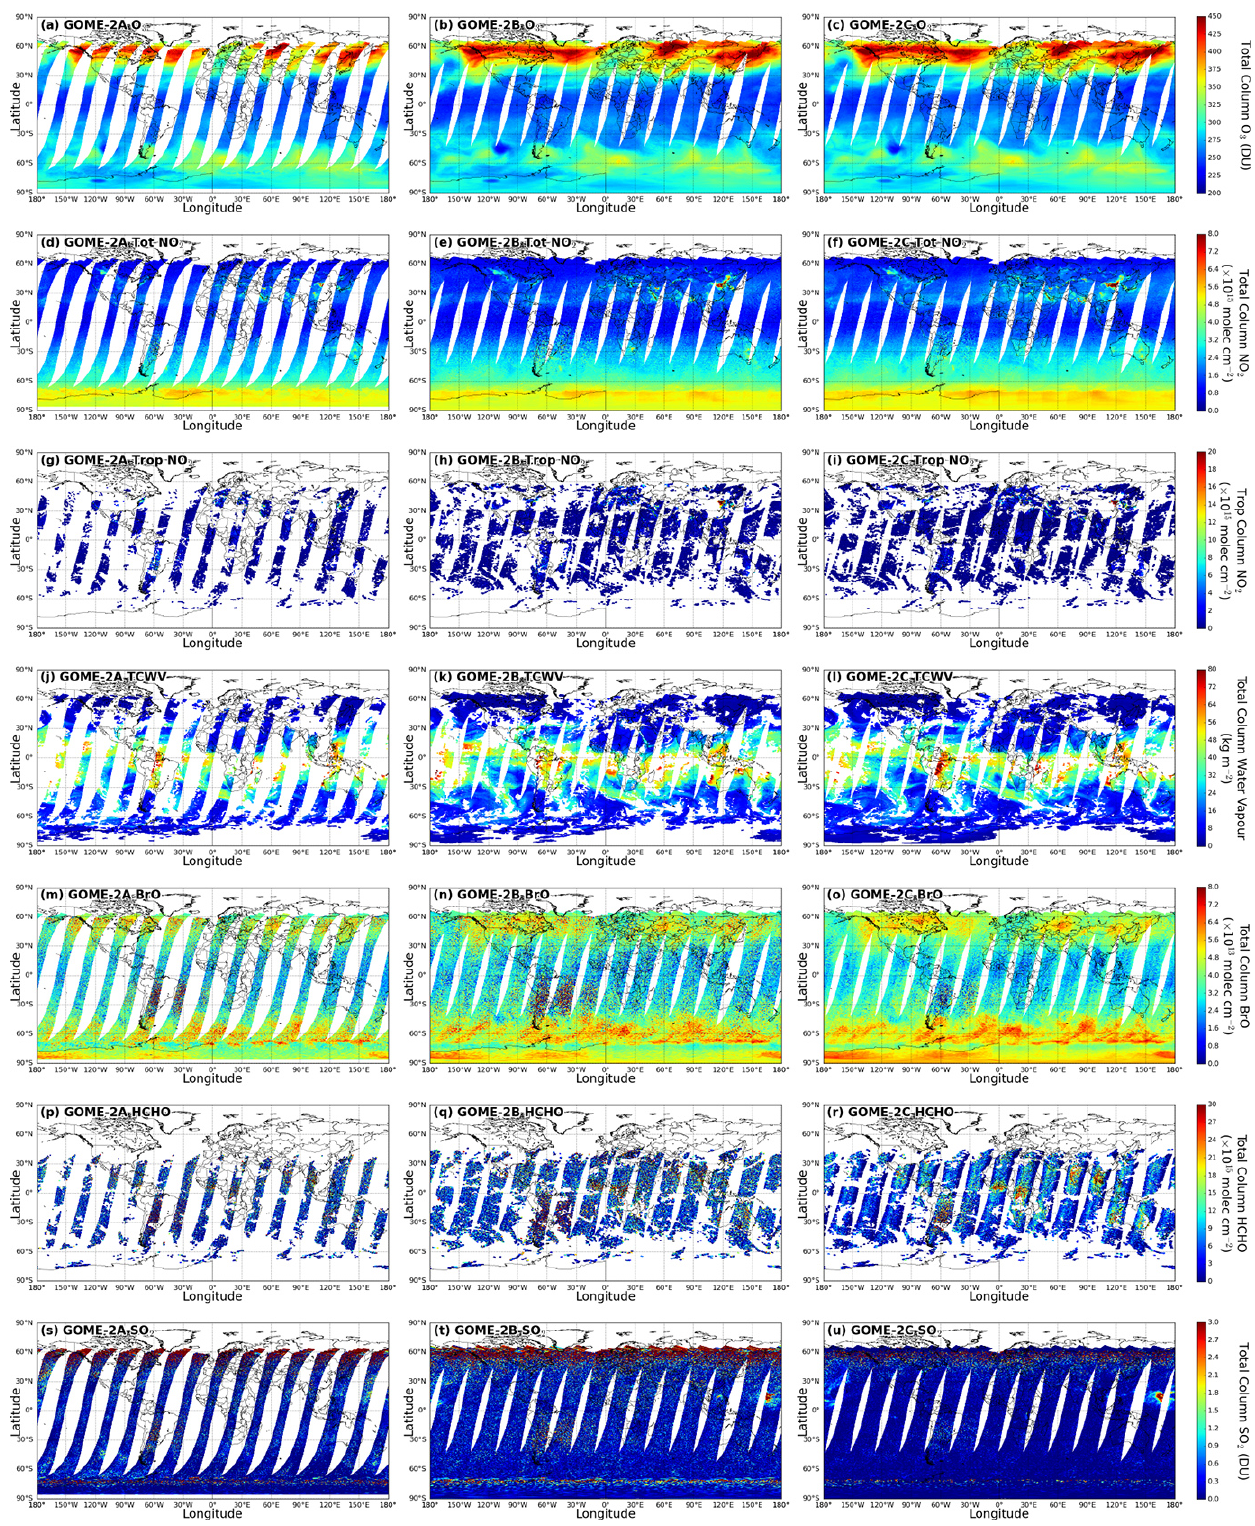
Figure 4. Daily level-3 product of GOME-2A (first column), GOME-2B (second column), and GOME-2C (third column) for 15 January 2020. Total column O 3 (first row), total column NO 2 (second row), tropospheric column NO 2 (third row), total column water vapour (fourth row), total column BrO (fifth row), total column HCHO (sixth row), and total column SO 2 (seventh row) are shown.